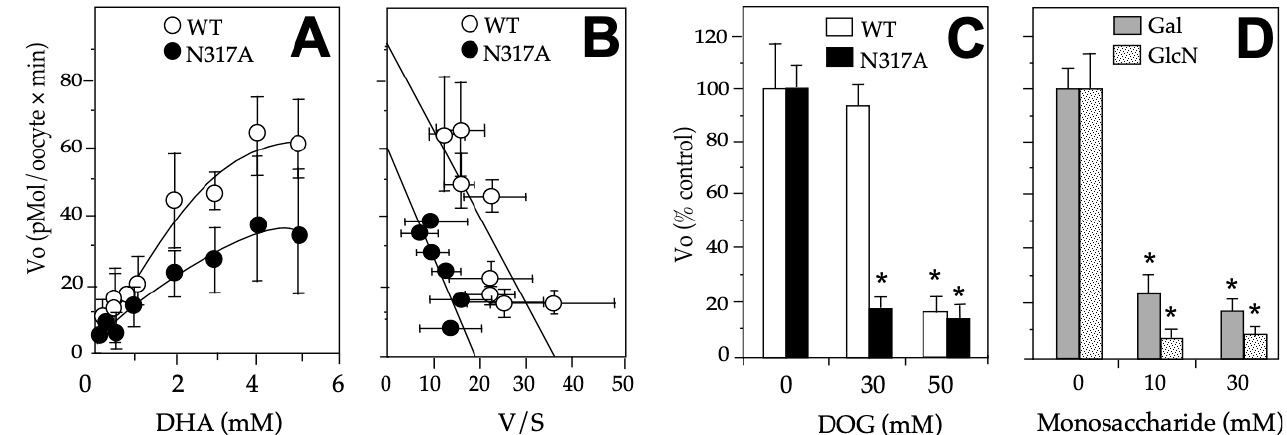
Figure 5. Effects of N317A on DHA transport on GLUT1. ( A ) DHA saturation curves of GLUT1 wildtype and N317A mutant; ( B ) Eadie-Hofstee transformation of the data shown in ( A ); ( C ) Effect of N317 in response to glucose. DHA’s transport in mutant N317A was performed in the presence of 30–50 mM glucose. ( D ) Effect of N317 in response to galactose and glucosamine. DHA’s transport in mutant N317A was performed in the presence of 10–30 mM galactose and galactosamine DHA. The data are expressed as mean ± SD of three experiments performed in triplicates. In ( C , D ), the results are presented as a percentage of the wildtype or mutant in the absence of the hexose explored, and 0.1 mM DHA was used. Xenopus laevis oocytes were injected with 40 ng of hGLUT1 or N317A mutant cRNA or if in the control, with equal volume of water. All the experiments were done at 8 min. For competition assays, hexoses were added simultaneously with DHA. DHA: dehydroascorbic